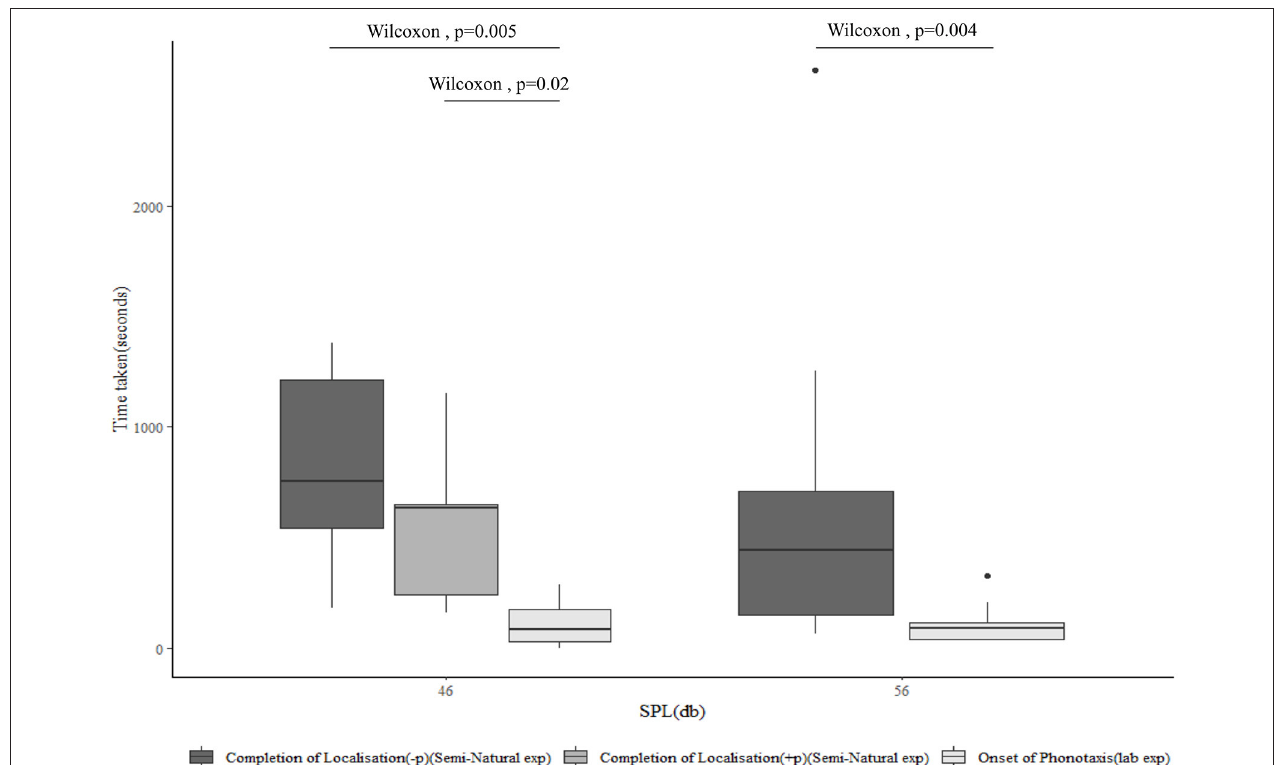
FIGURE 6 | The median latency of onset of phonotaxis as assessed in the laboratory experiment at 46 and 56 dB SPL ( n = 13), compared to time taken for the completion of vibrotaxis and localization of the female by the male as separately assessed in those treatments of the semi-natural experiment where the female does not perform phonotaxis, at 4m (54 dB SPL) ( n = 11) and 9m (47) dB SPL ( n = 10), and where the female does perform phonotaxis at 9m ( n = 4). All vibrotaxis latencies for this plot are calculated from the onset of female tremulation, while phonotaxis latencies are calculated from the onset of the male acoustic